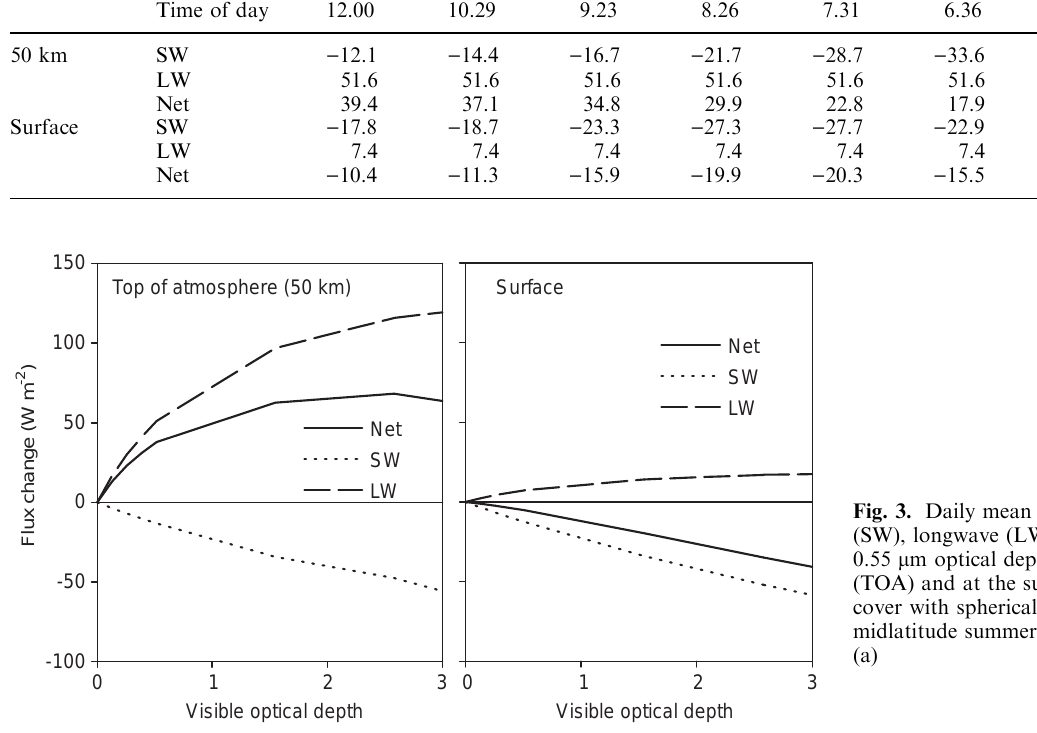
Fig. 3. Daily mean instantaneous shortwave (SW), longwave (LW), and net forcing versus 0.55 l m optical depth at 50 km altitude (TOA) and at the surface for 100% contrail cover with spherical ice particles for the midlatitude summer continent reference case (a)